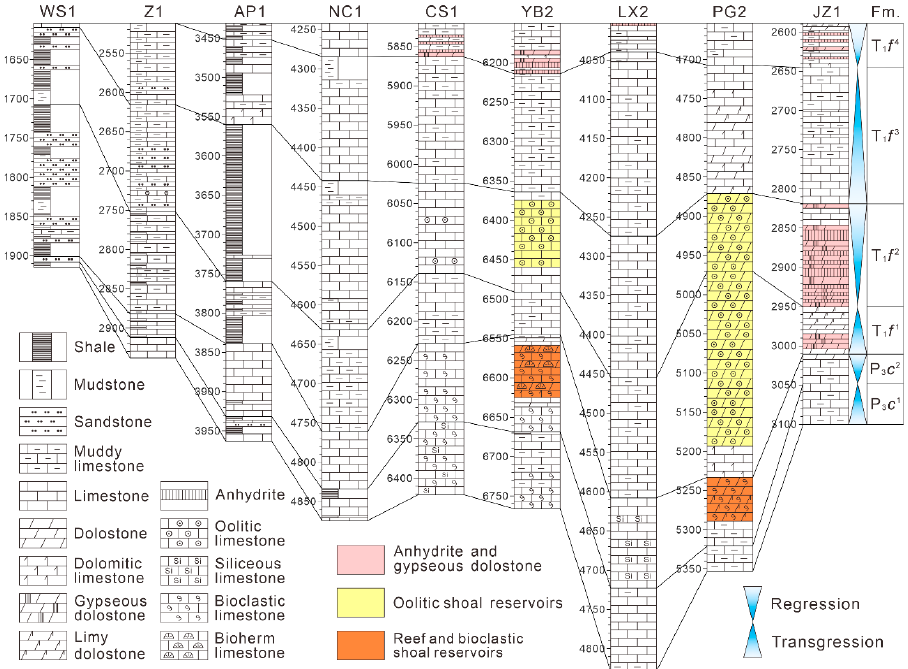
Figure 2. Lithologic variations in the P 3 c and T 1 f in the Sichuan Basin from southwest to northeast. The well locations are shown in Figure 1A.